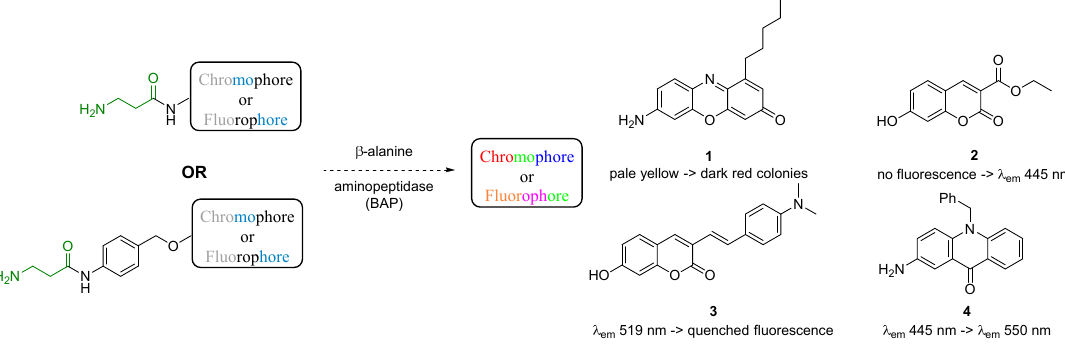
Scheme 1. Schematic representation of some amino and hydroxyl derivative chromogenic / fluorogenic probes used as β -alanyl aminopeptidase (BAP) substrates.